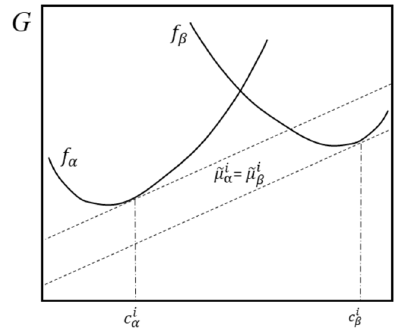
Figure 4. Schematic illustration of the quasi-equilibrium, parallel tangent law of solute elements between the α and β phases.